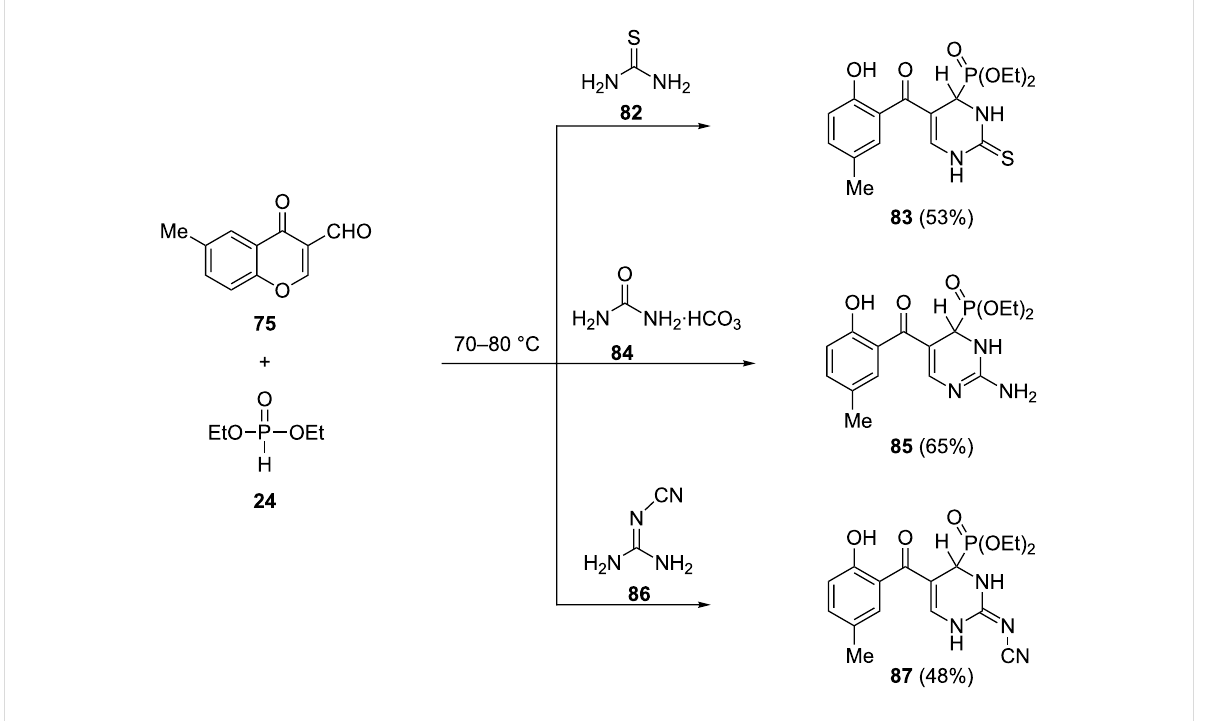
Scheme 20: Three-component reaction of 6-methyl-3-formylchromone ( 75 ) with thiourea, guanidinium carbonate or cyanoguanidine in the presence of diethyl phosphonate.